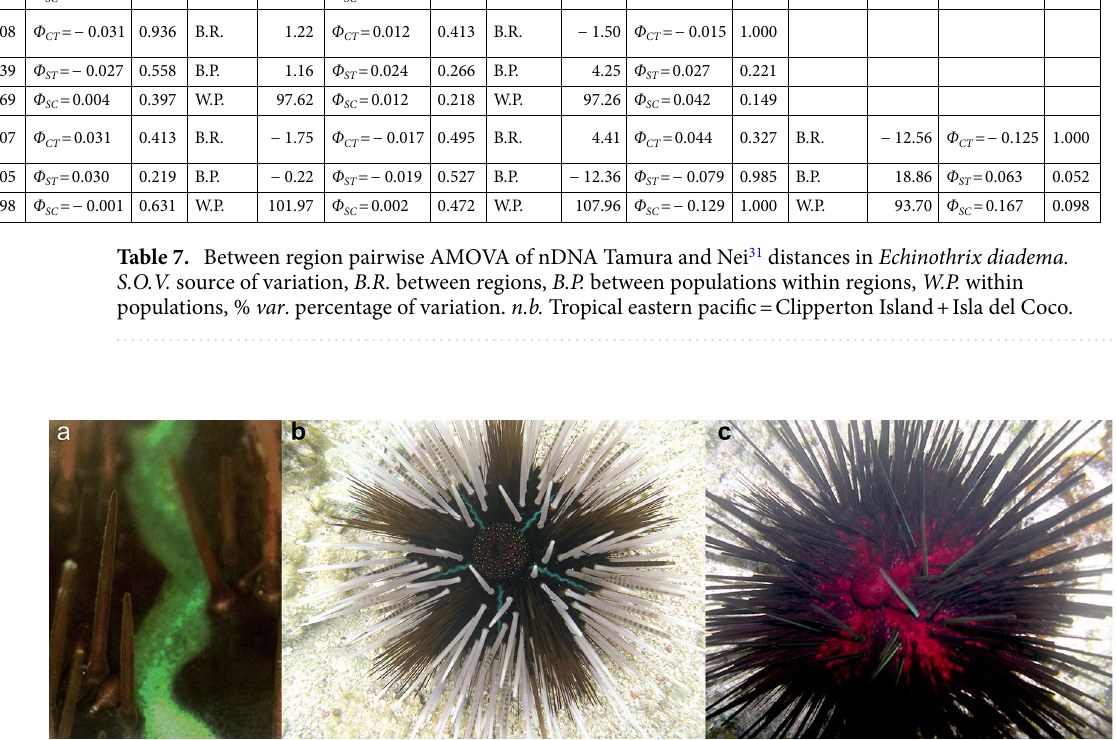
Figure 6. Green median regions of interambulacra in E. calamaris . ( a ) Close-up of median region, ( b ) white colour morph with green median regions (haplotype = clade 1, Namatakula, Fiji 13), (c) red colour morph with only red pigmentation in epithelial tissues of interambulacra (haplotype = clade 1, Namatakula, Fiji